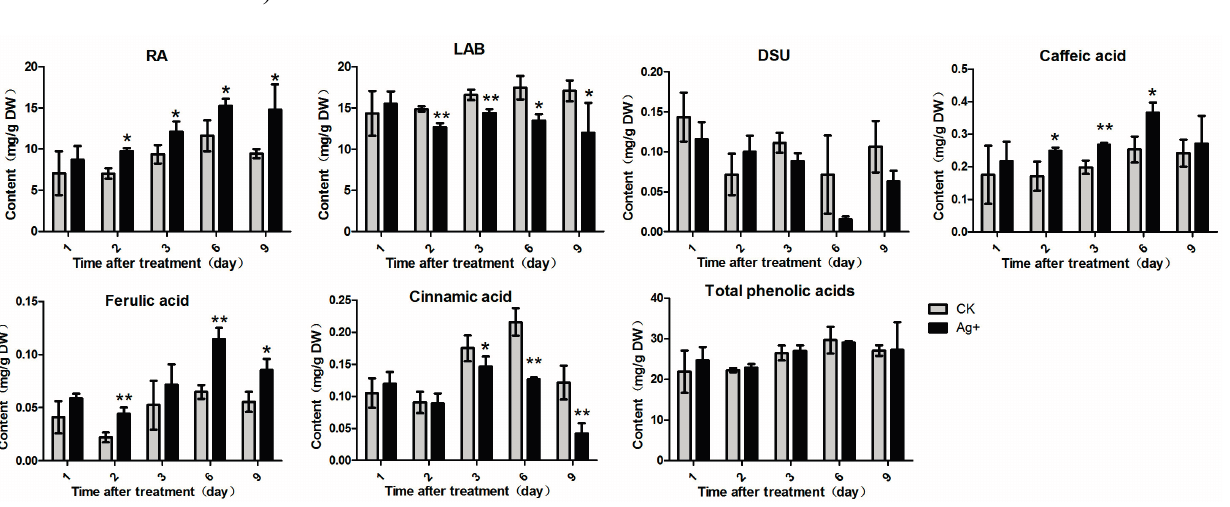
Figure 4. Effects of Ag + on accumulations of phenolic acids in S. miltiorrhiza hairy roots. Content of RA (rosmarinic acid), LAB (salvianolic acid B), DSU, caffeic acid, ferulic acid, cinnamic acid and total phenolic acids. The vertical bars show the SD values ( n = 3). The asterisks indicate statistically significant differences at p < 0.05 ( * , 0.01 < p < 0.05; ** , 0.001 < p < 0.01.) between the content in the elicitor treated cultures and that in the corresponding